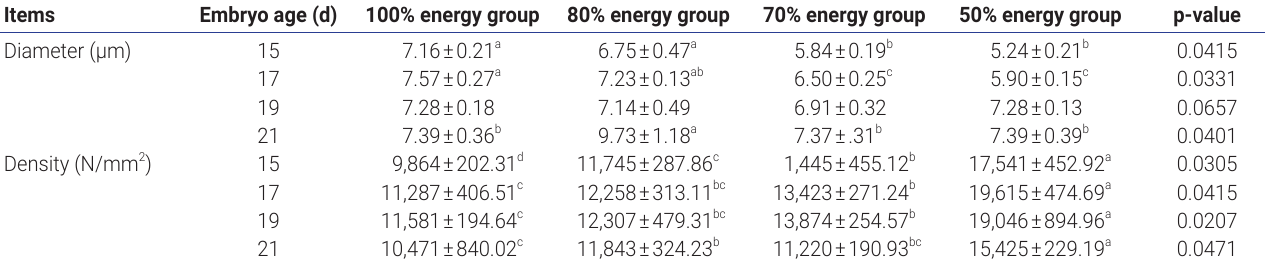
Table 4. Effects of maternal dietary energy restriction on diameter and density of breast muscle fiber in the embryo